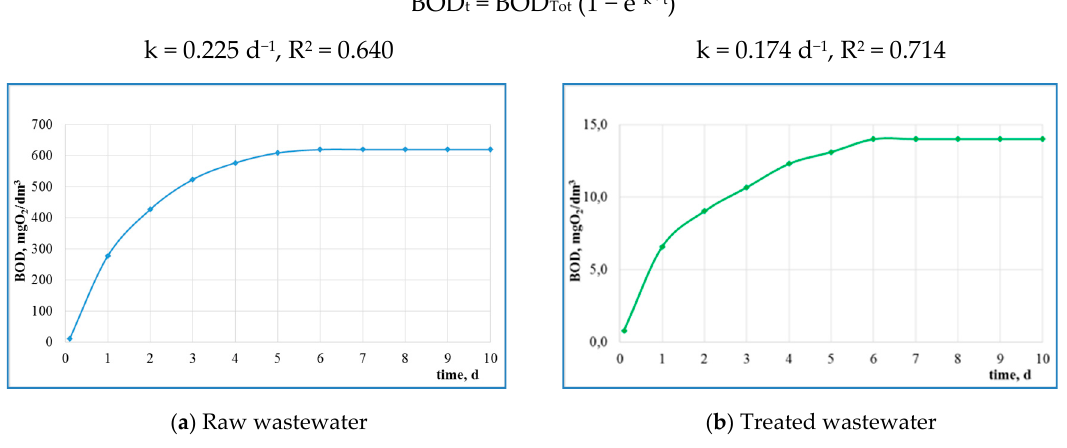
Figure 3. The course of BOD curves for raw and treated wastewater. ( a ) Raw wastewater; ( b ) treated wastewater.